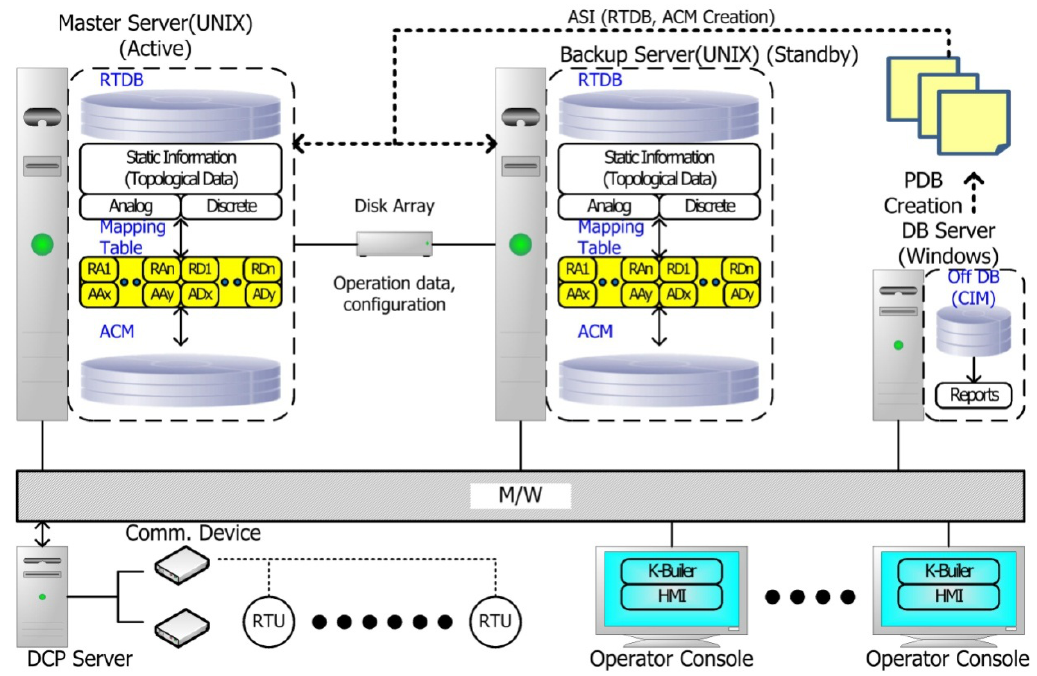
Figure 4. Database structure of